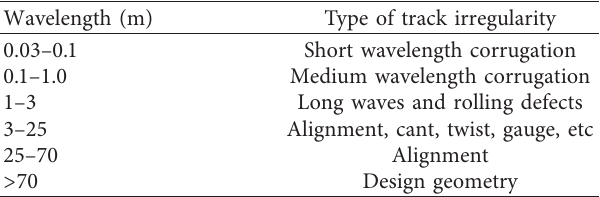
Table 1: Classification of track